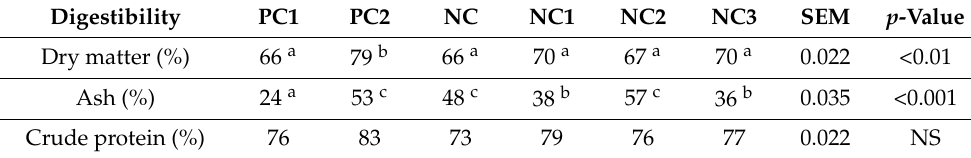
Table 6. The effect of the plant materials on the apparent ileal digestibility (%).